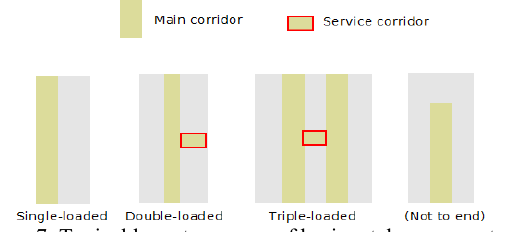
Figure 7. Typical layout manners of horizontal access systems